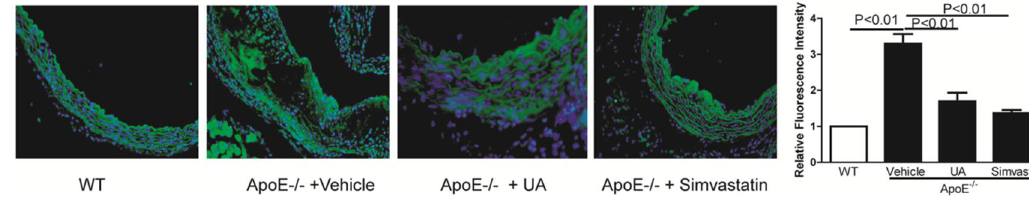
Figure 5. Expression of LOX-1 in the aorta was detected by immunofluorescence (4×). WT, wild type; ApoE −/− , apolipoprotein E-deficient; UA, ursolic acid.